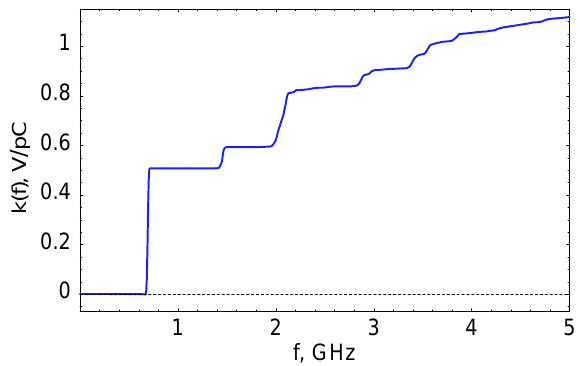
FIG. 8. (Color). Loss factor spectrum integrated up to a given frequency versus that frequency. Results from time-domain simulations with ABCI for a 3.5-mm bunch in the 5-cell APT b (cid:173) (cid:48)(cid:46)(cid:54)(cid:52)